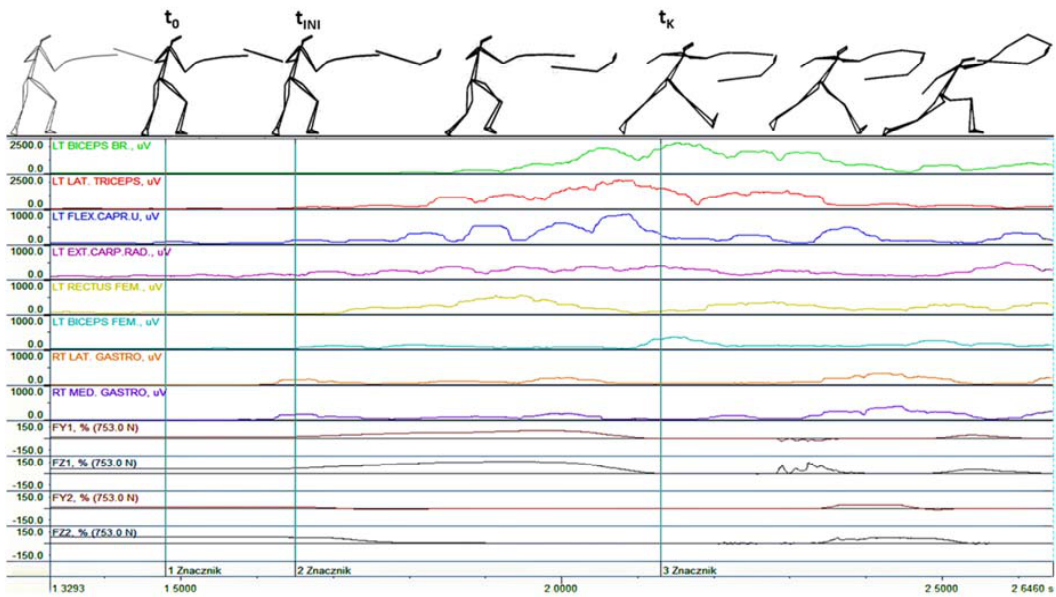
Figure 4. Bioelectric activity of selected muscles as well as the horizontal (FY1 and FY2) and vertical components (FZ1 and FZ2) of the ground reaction forces during an attack executed with a lunge in response to visual stimulation; 1—t 0 : Initiation of the move by the coach, 2—t INI : Fencer’s response, 3—t K : Instant of completion of the lunge.